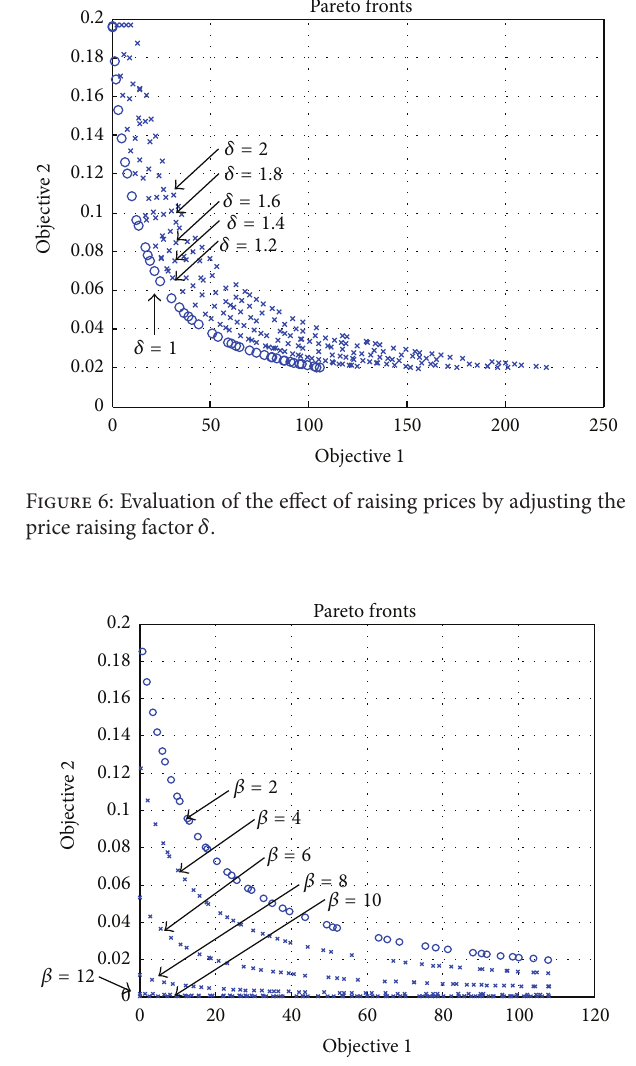
Figure 7: Evaluation of the effect of changing sensitivity of satisfac- tion on